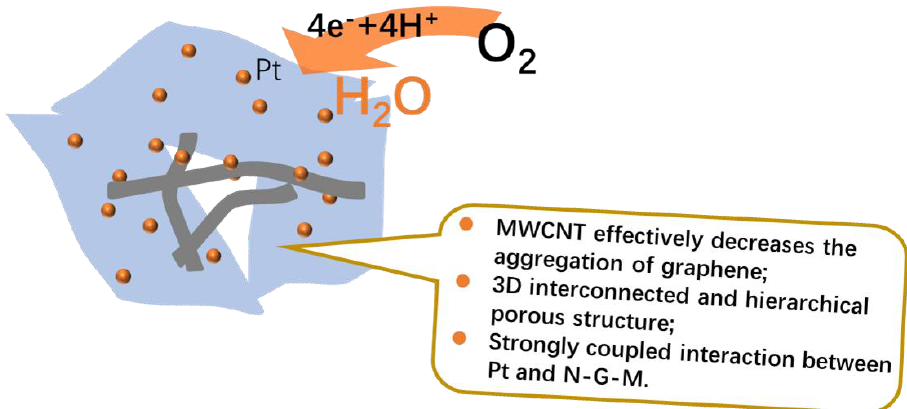
Figure 8. The proposed reasons for the enhanced catalytic activity of Pt/N-G-M catalysts for ORRs.